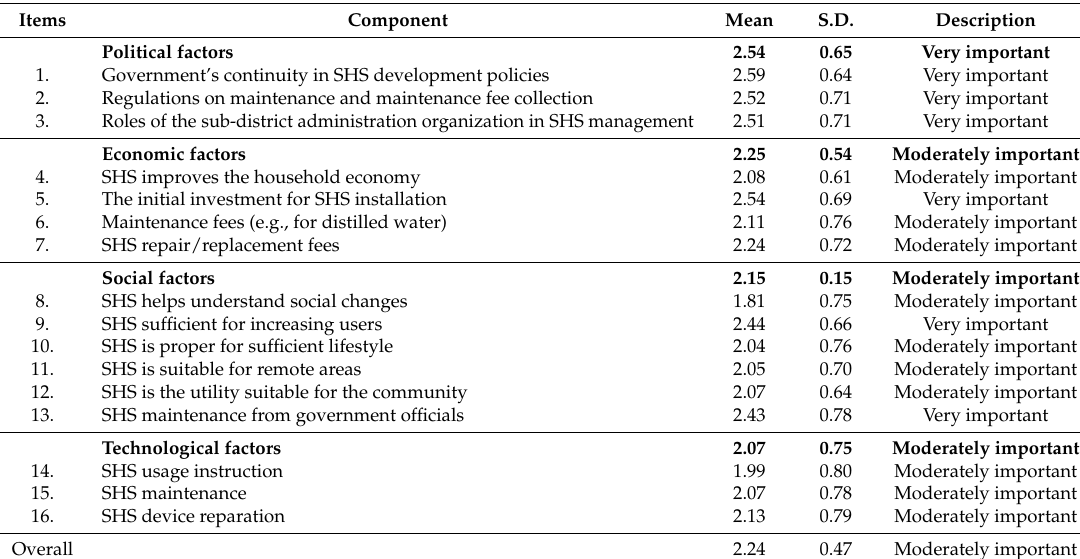
Table 2. External factors affecting sustainable SHS development.